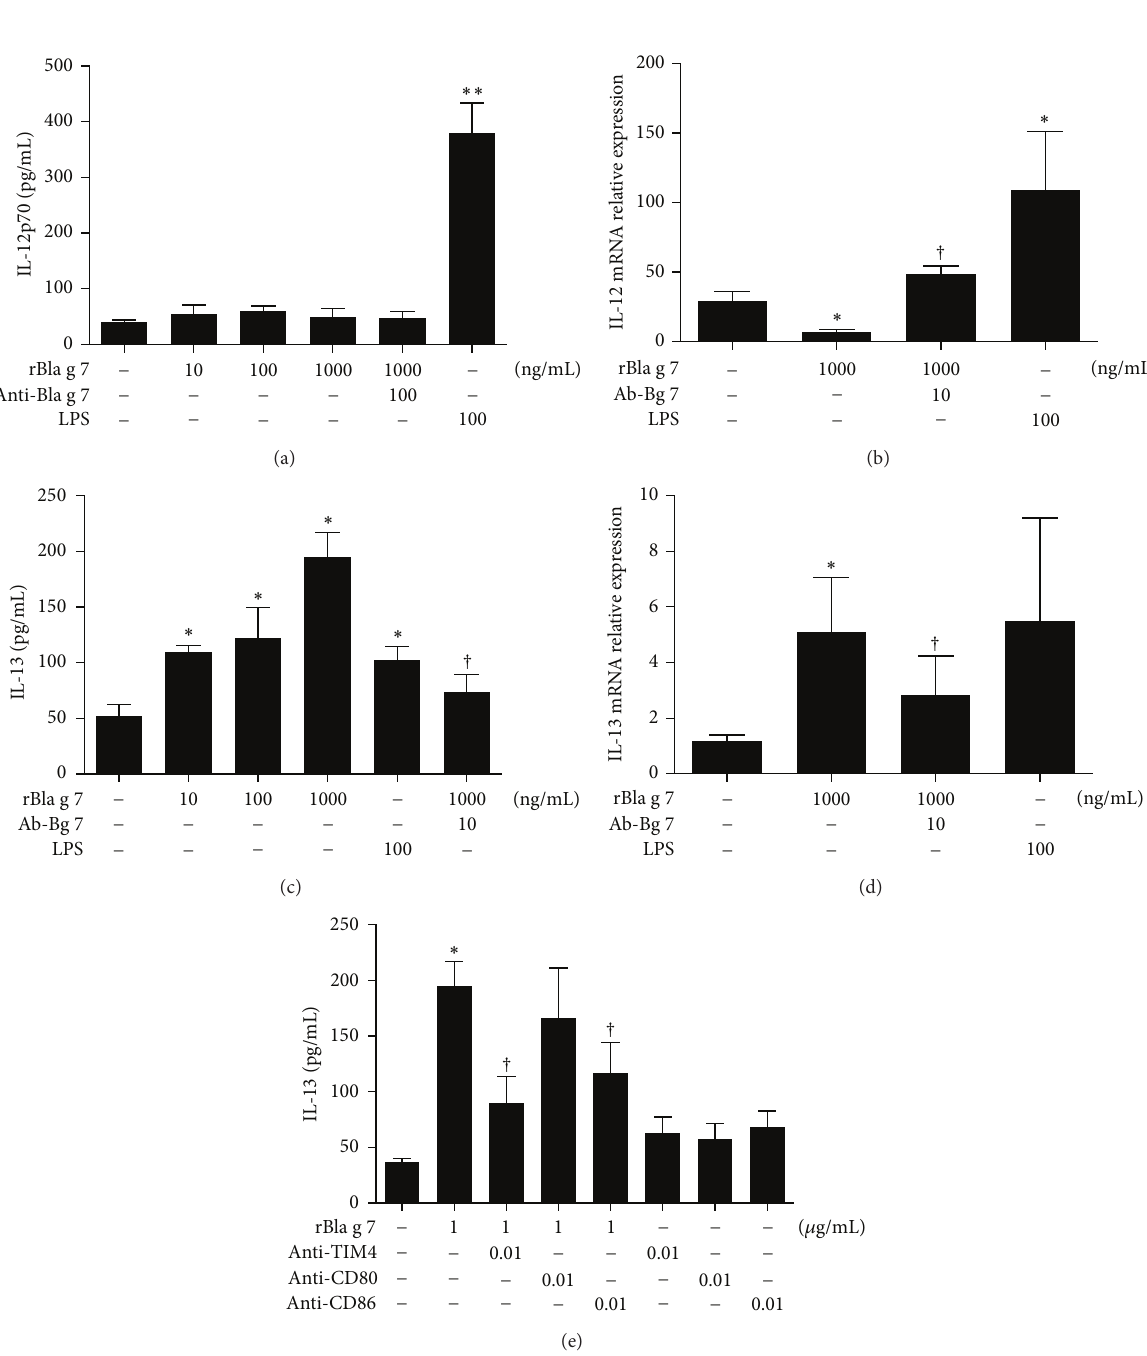
Figure 3: rBla g 7 induced release of IL-13 from dendritic cells (DCs). DCs were incubated with various concentrations of rBla g 7 (ng/mL) with or without its specific blocking antibody (Ab-Bg 7, 10ng/mL), or with LPS for 48h at 37 ∘ C. The levels of IL-12 (a) and IL-13 (c) in the culture supernatant were determined by ELISA, and the expression of IL-12 (b) and IL-13 (d) mRNAs was assessed by real-time PCR. The influence of TIM4, CD80, and CD86 blocking antibodies on rBla g 7 provoked IL-13 release was also examined (e). The data were represented as the mean ± SEM for four separate experiments. ∗ 𝑃 < 0.05 in comparison with medium alone control. † 𝑃 < 0.05 compared with the response to the corresponding uninhibited